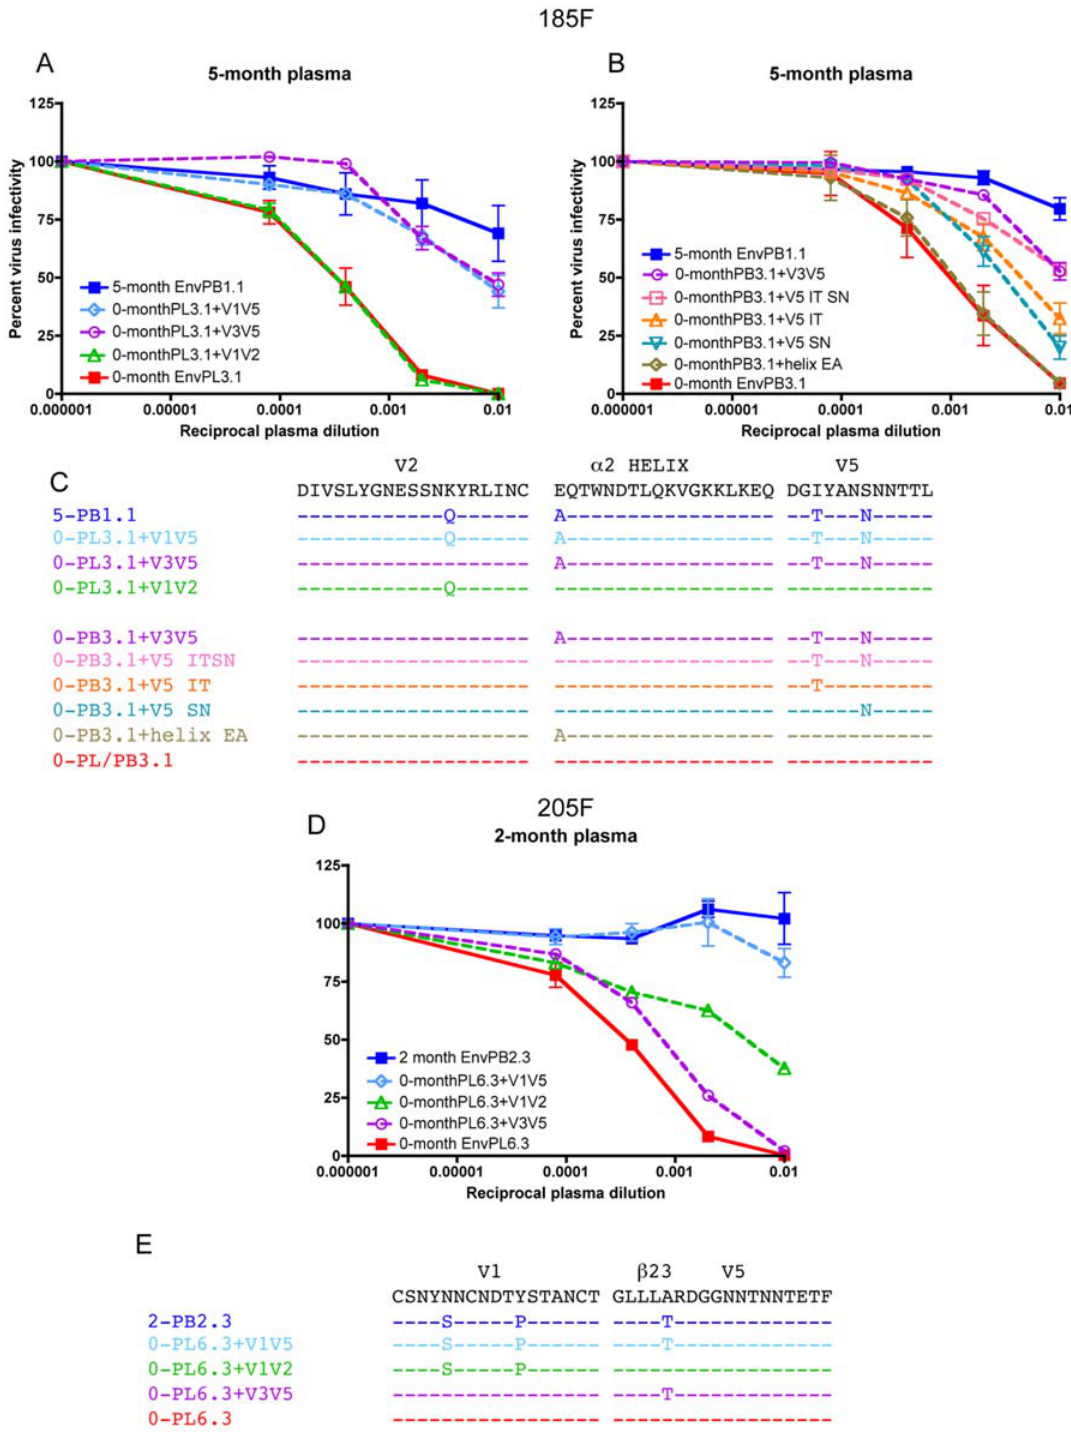
Figure 3. Early escape from neutralization in 185F and 205F requires different pathways. Neutralization of escape variants 185F 5-month PB1.1 (A and B) , and 205F 2-month PB2.3 (D) and chimeras or mutants from each of these Envs in the corresponding 0-month Env was evaluated using contemporaneous plasma. Pseudoviruses were created by expressing each Env with an HIV-1 env -deficient backbone, and their infectivity for JC53-BL13 (Tzm-bl) cells was evaluated in the absence or presence of serially-diluted patient plasma with luciferase as a quantitative measure. Percent virus infectivity relative to no test plasma is plotted on the vertical axis; the reciprocal of the plasma dilution is plotted along the horizontal axis on a log10 scale. Each curve represents one Env against serial plasma dilutions, and error bars represent the standard deviation of at least two independent experiments using duplicate wells. The legends list the parental Nab resistant Env followed by the chimeric and mutant Envs created in the 0-month Env background. Amino acid alignments are shown to indicate the sequence differences between the different Envs for 185F (C) and 205F (E) . The color of the text corresponds to the curves on the graph. Only regions that contained differences are shown.